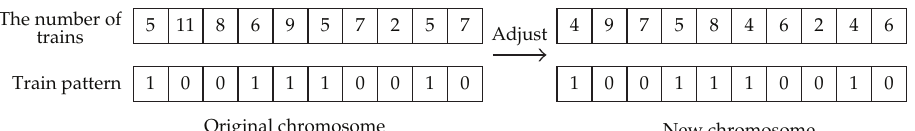
Figure 3: The adjustment of an infeasible